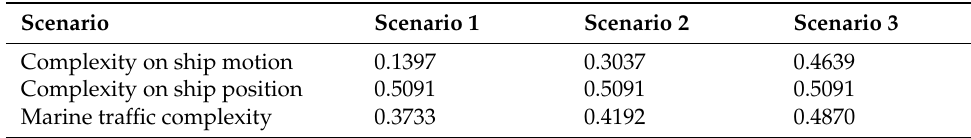
Table 9. The results of the expanded case